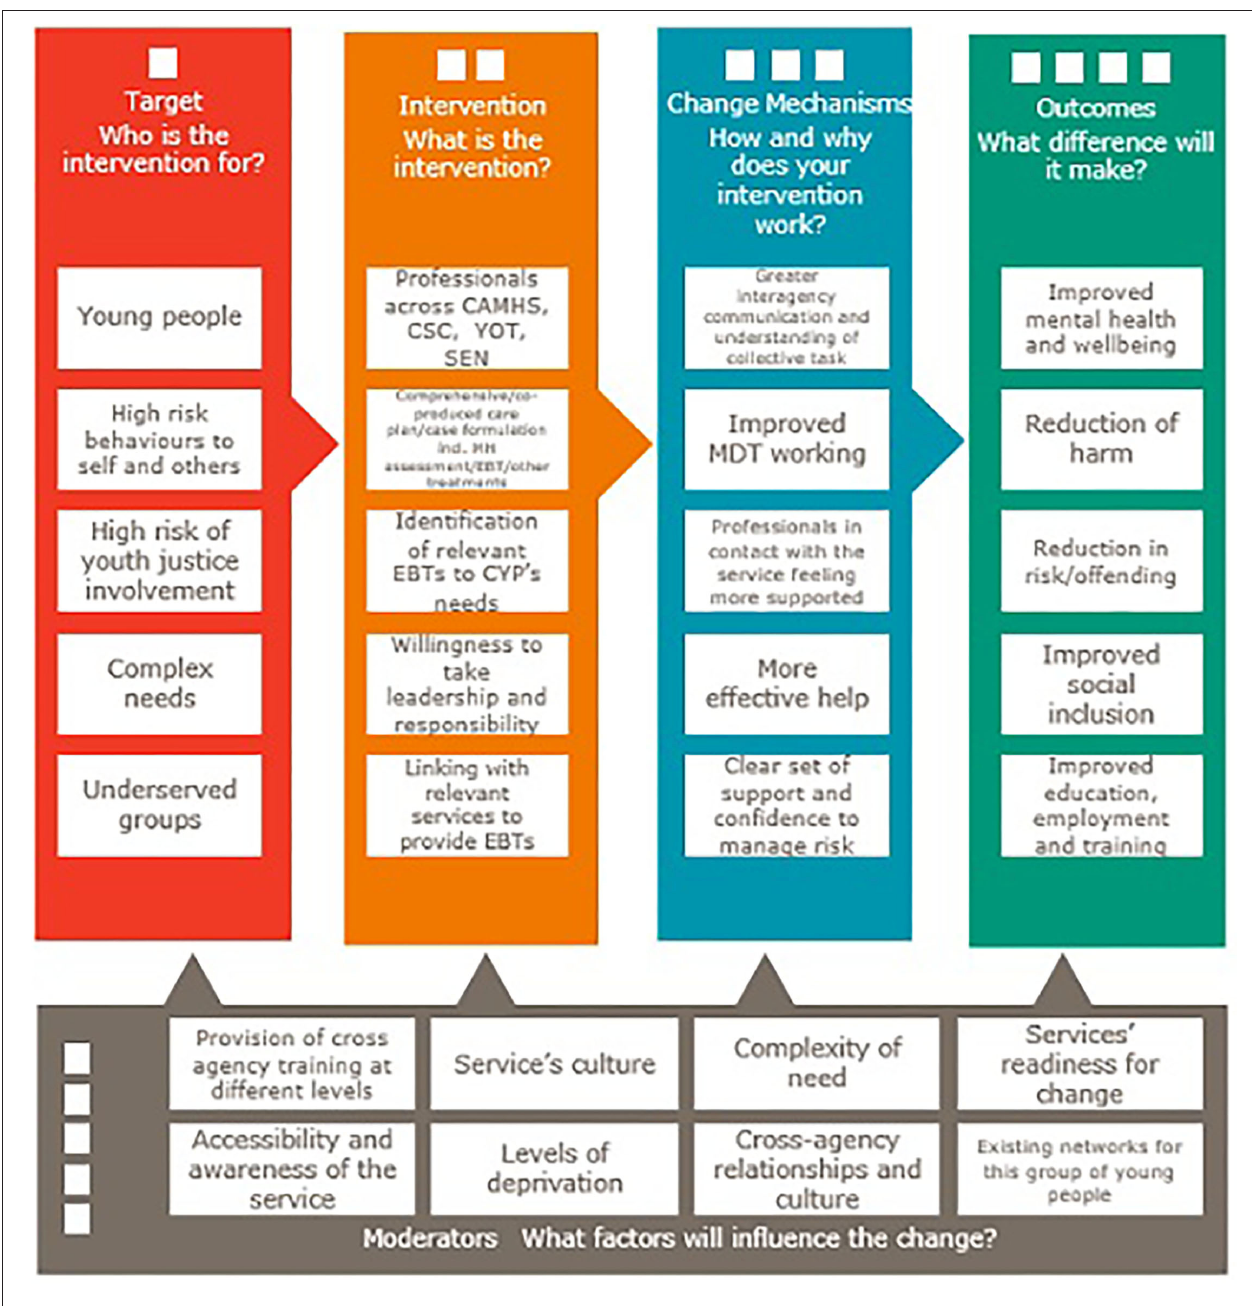
FIGURE 1 | Logic model for community F:CAMHS